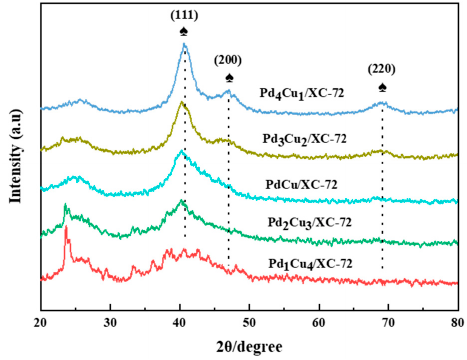
Figure 1. XRD pattern of the electrocatalysts.